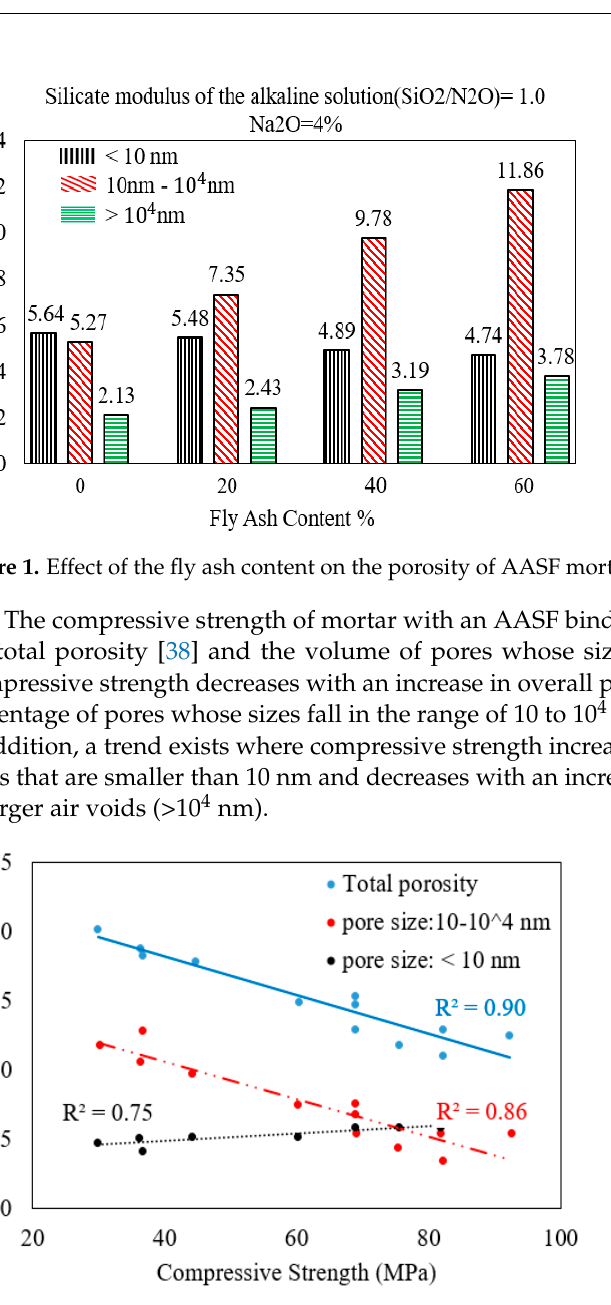
Figure 2. Effect of pore sizes on the strength development of AASF mortar [38].